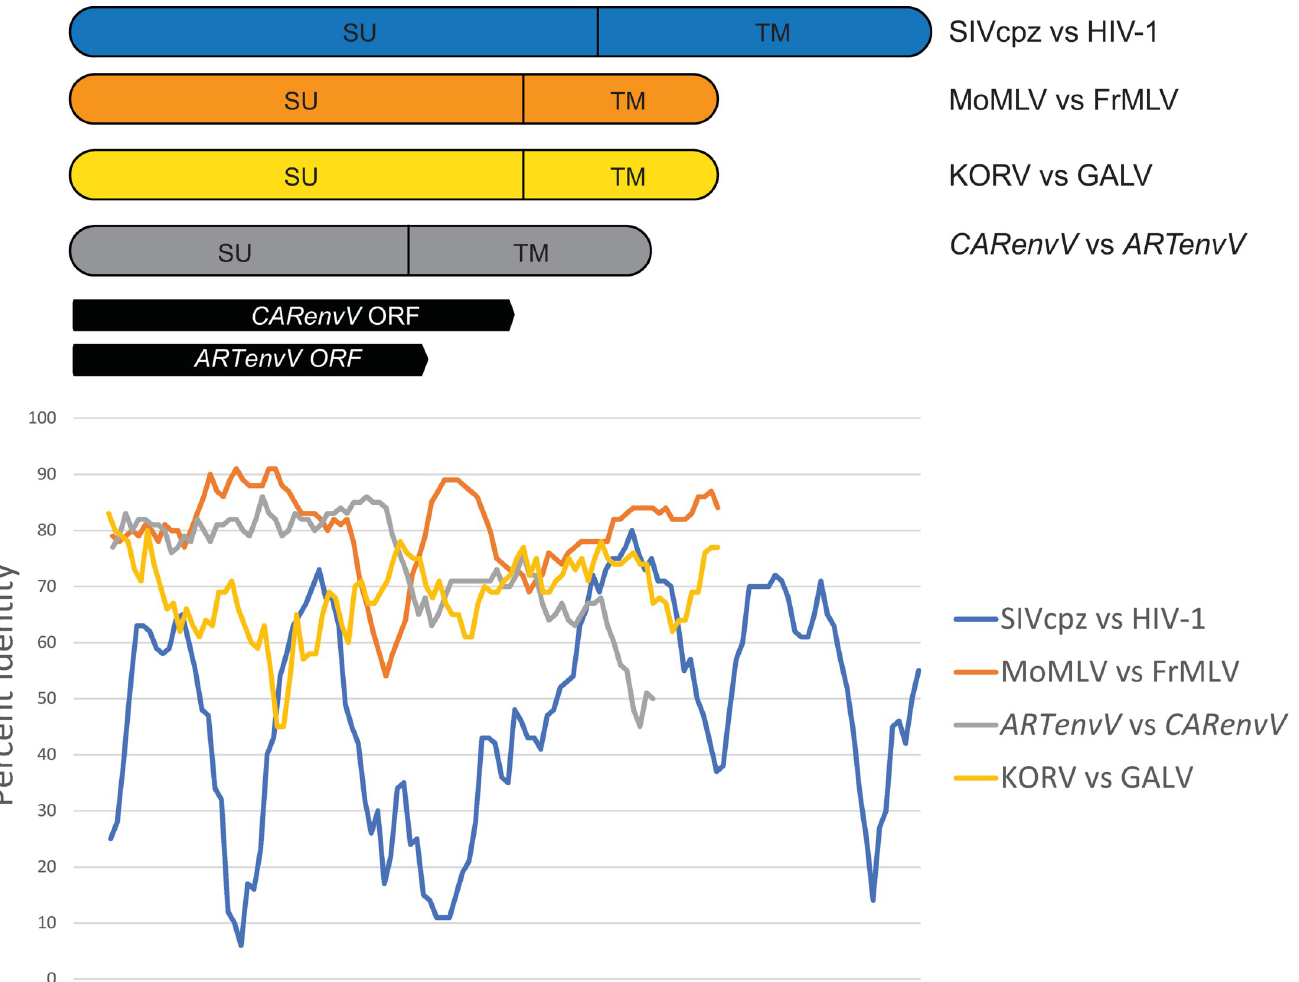
Fig 7. CARenvV and ARTenvV show high nucleotide identity in SU env . Sliding window analysis of percent nucleotide identity along pairwise alignments of CARenvV and ARTenvV as well as the env genes of the indicated retroviruses. The location of the ORFs of CARenvV and ARTenvV relative to the sequence alignment, the relative sizes of the env genes as well as the location of the SU and the TM domains for each alignment are shown above the